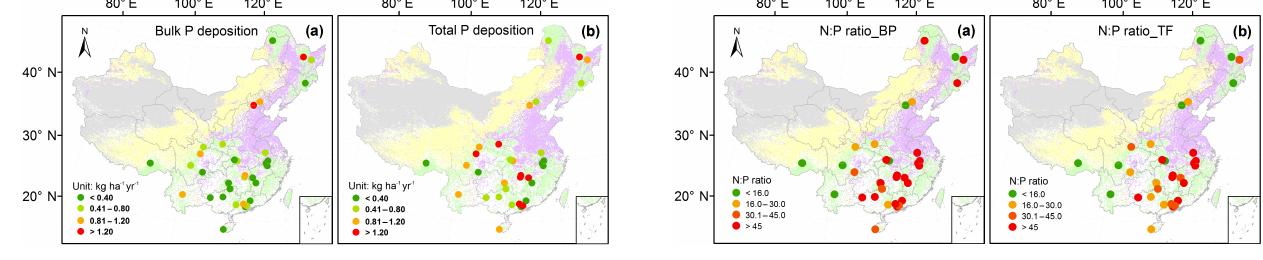
Figure 1. Spatial patterns of (a) bulk P deposition (kgha − 1 yr − 1 ) and (b) total P deposition (kgha − 1 yr − 1 ) in China’s forests. The background shading in light green, light yellow, light purple and light grey indicates the distribution of forest, grassland (semiarid region), cropland and non-vegetated land, respectively.